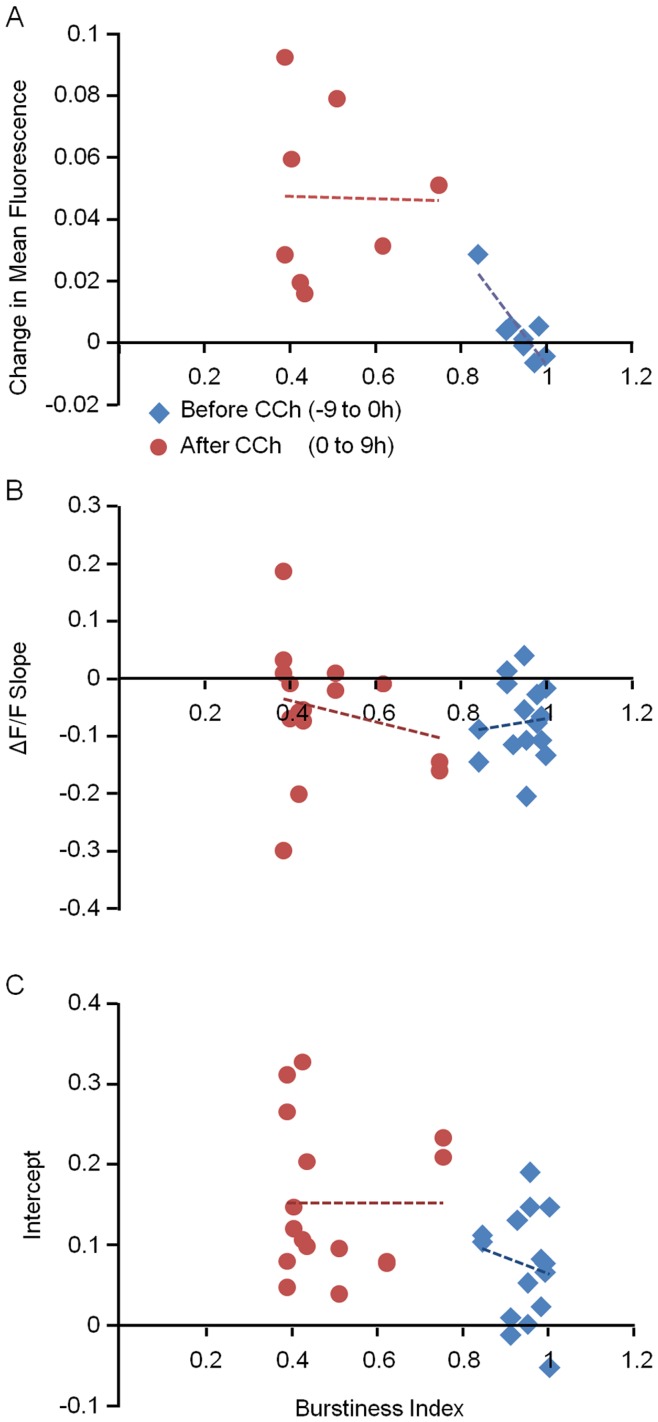
Synchronous bursting activity and measures of synaptic remodeling are not strongly correlated.Data from 8 different experiments (16 tracked sites) in 9 hour windows before (blue) and after (red) CCh application. Lines represent linear regression fits made separately for each group. The four panels show correlations between the burstiness index and A) changes in mean synaptic PSD95:EGFP fluorescence (each point represents mean change in fluorescence of all synapses of all neurons in a certain experiment), B) slopes of the ΔF vs. F0 plots (each point represents data from tracked synapses from one site), and C) the intercepts in the same plots.